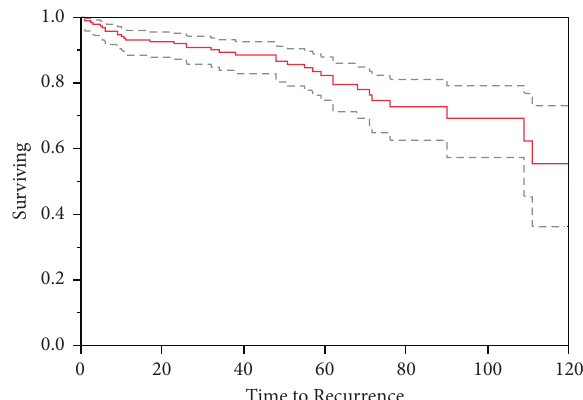
Figure 3: 10-year recurrence-free survival with 95% confidence intervals represented by dotted